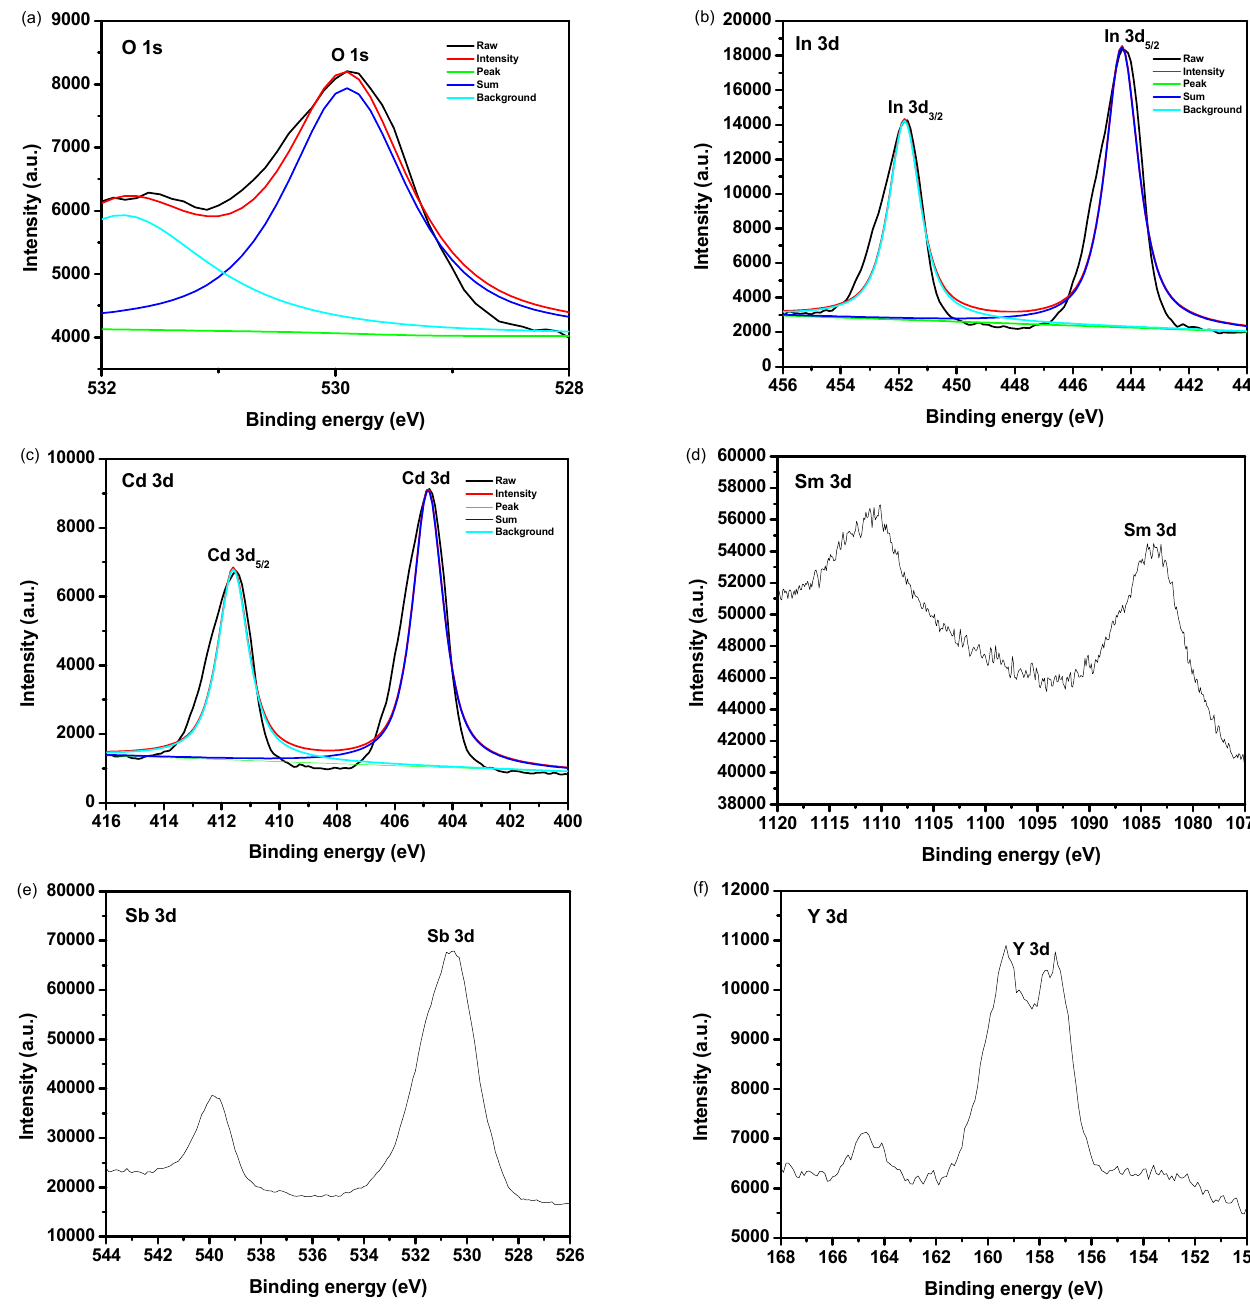
Figure 8. ( a ) XPS spectra of O 2- which originated from the In 2 CdO 4 /Y 2 SmSbO 7 heterojunction; ( b ) XPS spectra of In 3+ which originated from the In 2 CdO 4 /Y 2 SmSbO 7 heterojunction; ( c ) XPS spectra of Cd 2+ which originated from the In 2 CdO 4 /Y 2 SmSbO 7 heterojunction; ( d ) XPS spectra of Sm 3+ which originated from the In 2 CdO 4 /Y 2 SmSbO 7 heterojunction; ( e ) XPS spectra of Sb 5+ which originated from the In 2 CdO 4 /Y 2 SmSbO 7 heterojunction; ( f ) XPS spectra of Y 3+ which originated from the In 2 CdO 4 /Y 2 SmSbO 7 heterojunction.